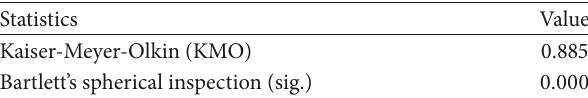
Table 5: KMO and Bartlett’s spherical